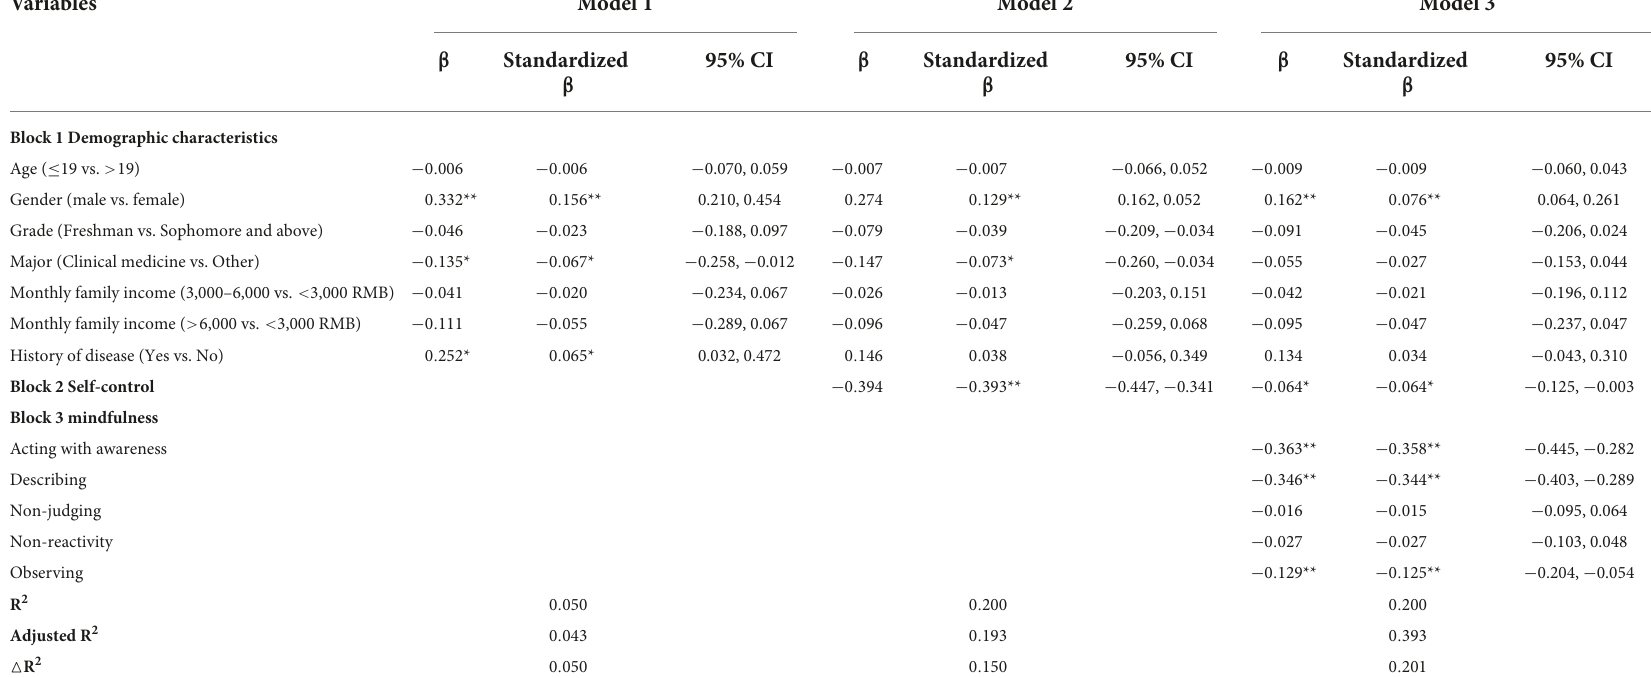
TABLE 3 The hierarchical linear regression analysis of